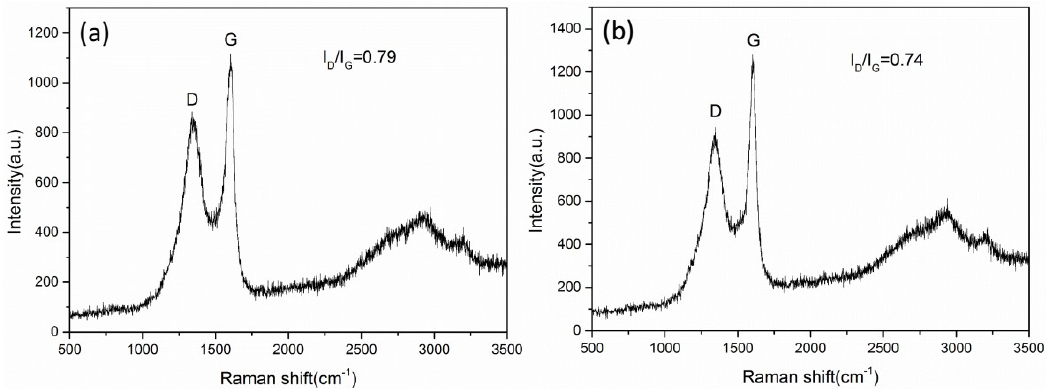
Figure 7. Raman spectra of carbon nanotubes when the deposition time is 1.5 h ( a ) and 2 h ( b ).